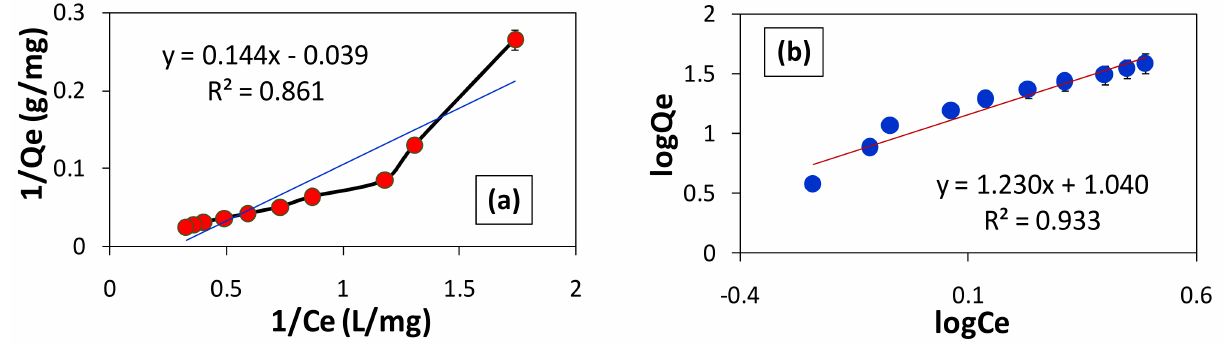
Figure 8. ( a ) Langmuir isotherm plot. ( b ) Freundlich isotherm